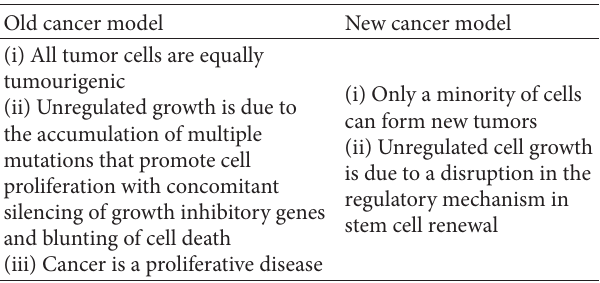
Table 1: Important features of old and new cancer model